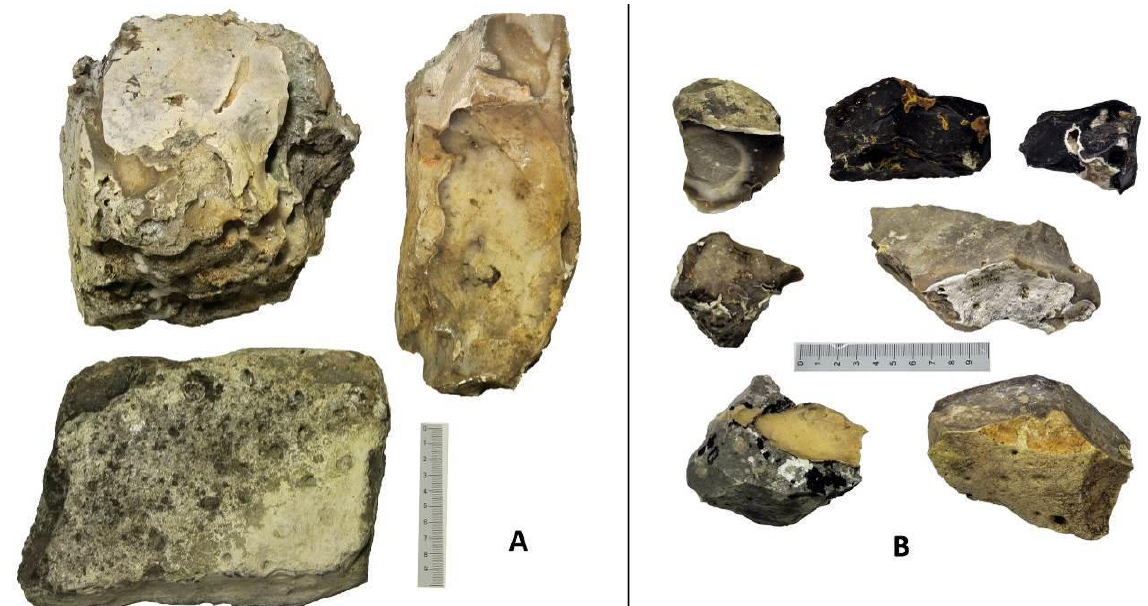
Figure 11. Chert pieces from Las Canteras. A: Nodules. B: Nodules and remains of cores used for experimental knapping.